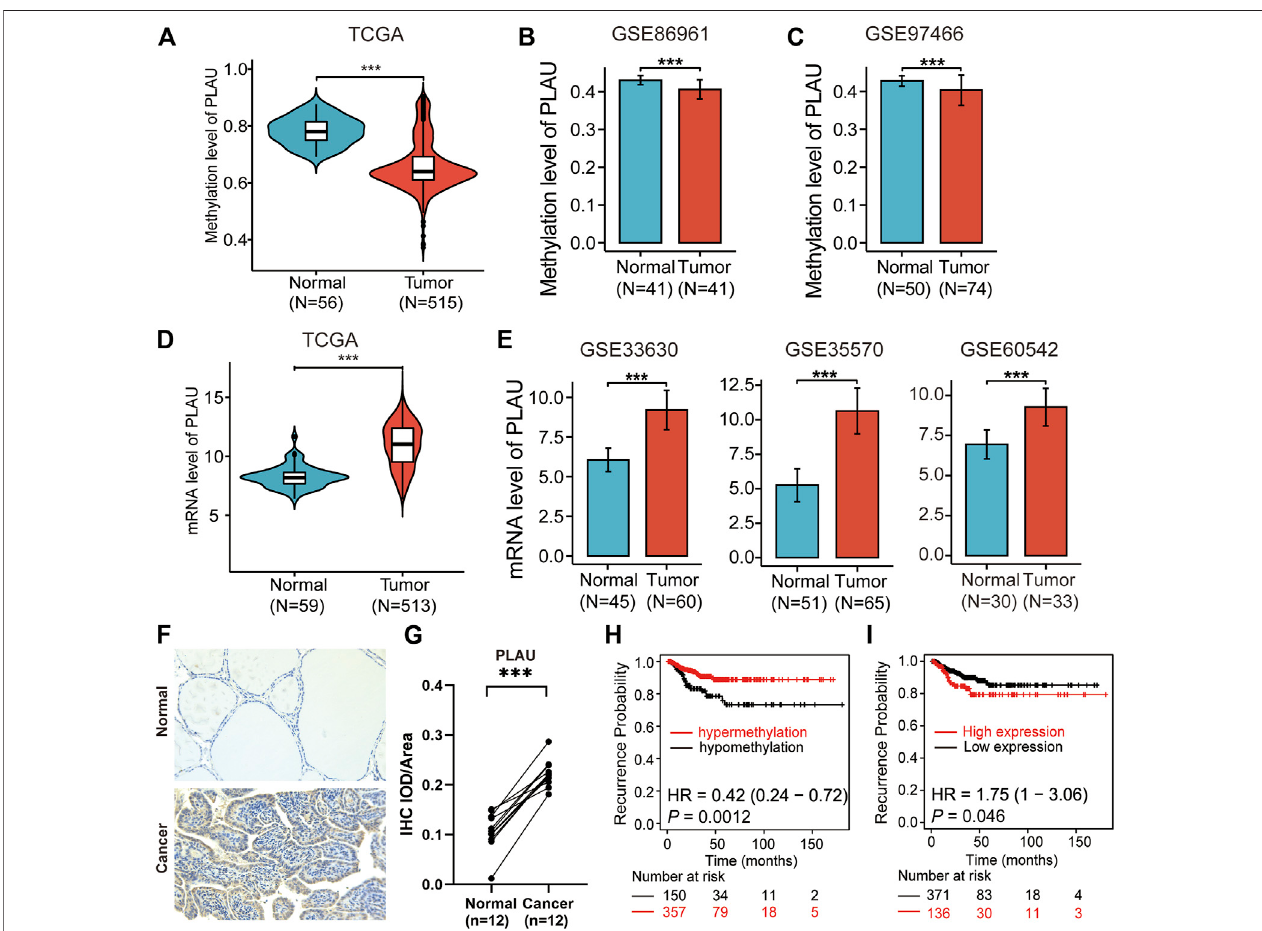
FIGURE 3 | Validation of methylation levels and the expression of PLAU in THCA. Violin plots showing (A) the methylation levels and (D) mRNA levels of PLAU between normal and tumor tissuesin THCA patients, Student ’ s t-test, *** p < 0.001. (B,C) Validation of the methylation levels of PLAU in THCA using data from the GEO database (GSE89961 and GSE97466), Student ’ s t-test, *** p < 0.001. (E) Comparison of the expression of PLAU between normal and tumor tissue in THCA patients using data from the GEO database (GSE33630, GSE35570 and GSE60542), Student ’ s t-test, *** p < 0.001. (F,G) Detection of the expression of PLAU in 12 pairs of matched cancerous and para-cancerous tissues of DTC via immunohistochemistry (IHC), Student ’ s t-test, *** p < 0.001. Kaplan-Meier plot for relapse-free survival (RFS) in THCA patients with different (H) methylation levels or (I) mRNA levels of PLAU.